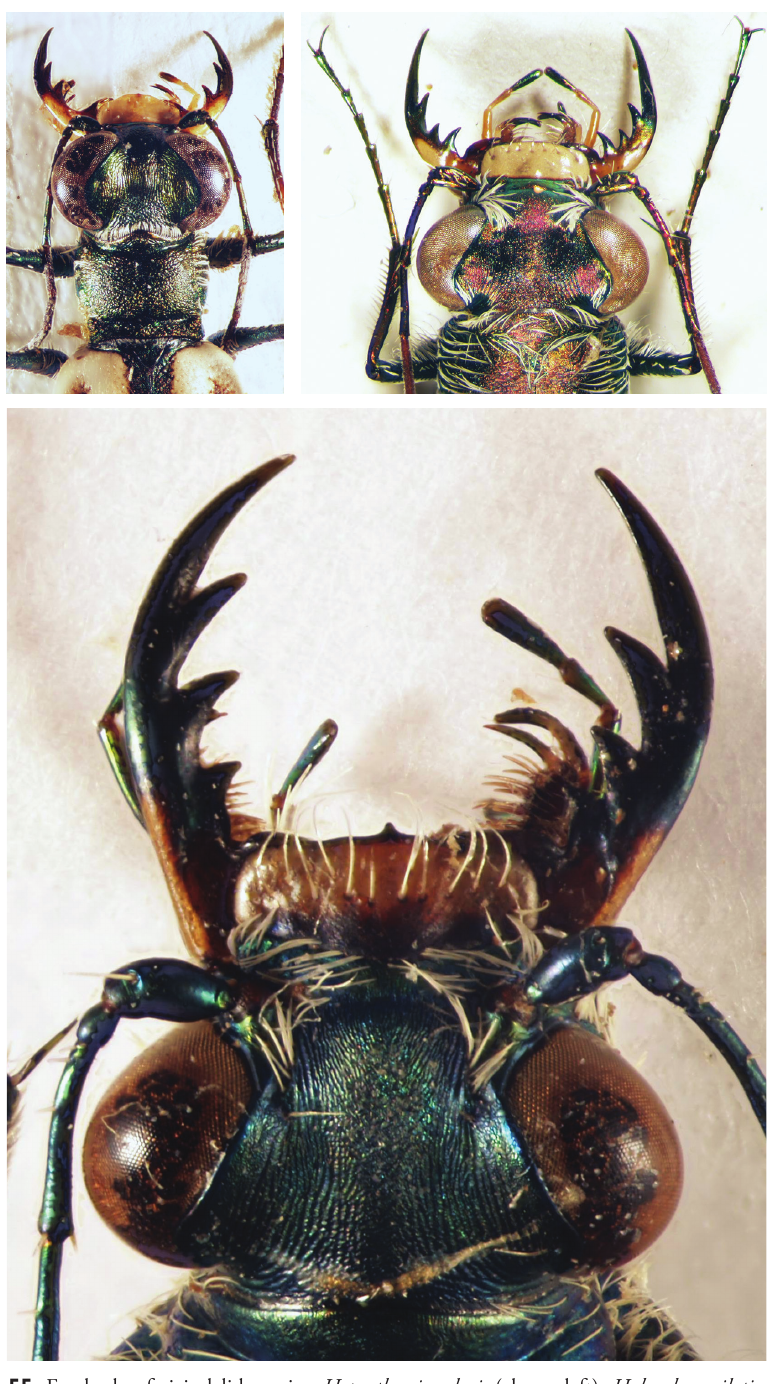
Figure 55. Forebody of cicindelid species: Hypaetha singularis (above, left), Habrodera nilotica (above, right), and Calomera alboguttata